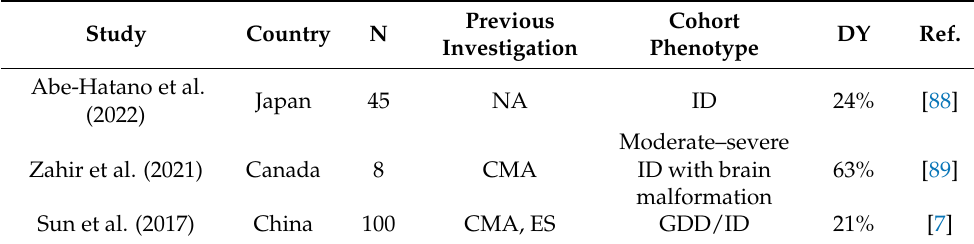
Table 6. Genome sequencing of individuals with intellectual disabilities/developmental disabilities in recent